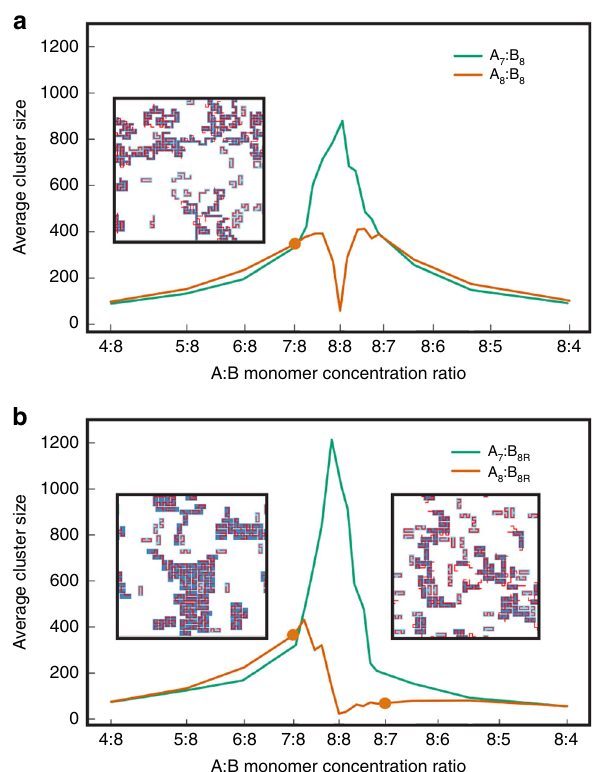
Fig. 3 Relative concentration of monomers strongly in fl uences